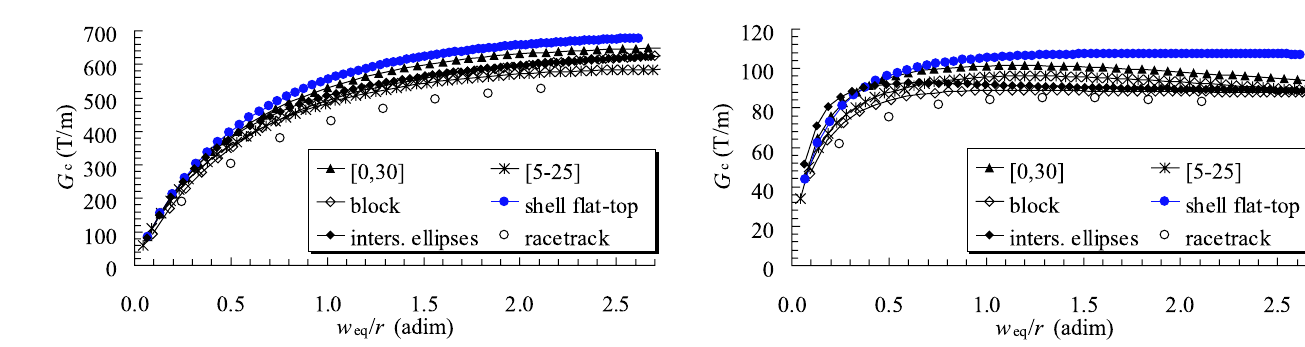
FIG. 21. (Color) Numerical evaluation of the critical gradient versus equivalent sector width (41) in six coil layouts with an aperture radius of 10 mm ( (cid:3) (cid:2) 0 : 28 ).